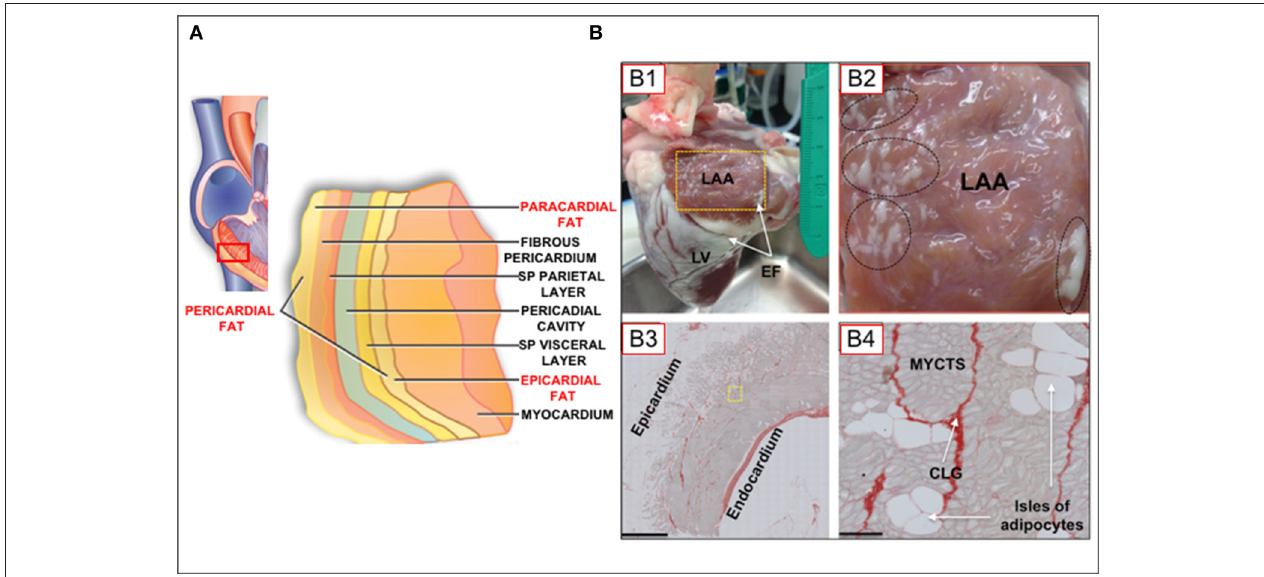
FIGURE 1 | (A) Schematic of myocardial fat depots in the myocardial wall of the right ventricle (Modified from Wong et al., 2016). (B) Epicardial fat tissue distribution in the ovine heart. (B) Normal adult sheep heart showing atrial and ventricular epicardial fat deposits. LAA, left atrial appendage; LV, left ventricle; EF, epicardial fat, on atrial and ventricular surfaces. Yellow box in (B1) is 2 × 3cm. (B2) , [Inset of box from (B1) ] Oval and circles represent regions of dense atrial epicardial fat. (B3) , LAA tissue section. Note significant epicardial fat layer with extensive adipocyte infiltration of the atrial muscle (Scale bar; 1mm). (B4) , Tissue section of a region near yellow inset in (B3) , showing myocytes (MYCTS), isles of adipocytes, and collagen (CLG; Picoserius staining). Scale bar: 50 µ m. (Modified from O’Connell et al., 2015).